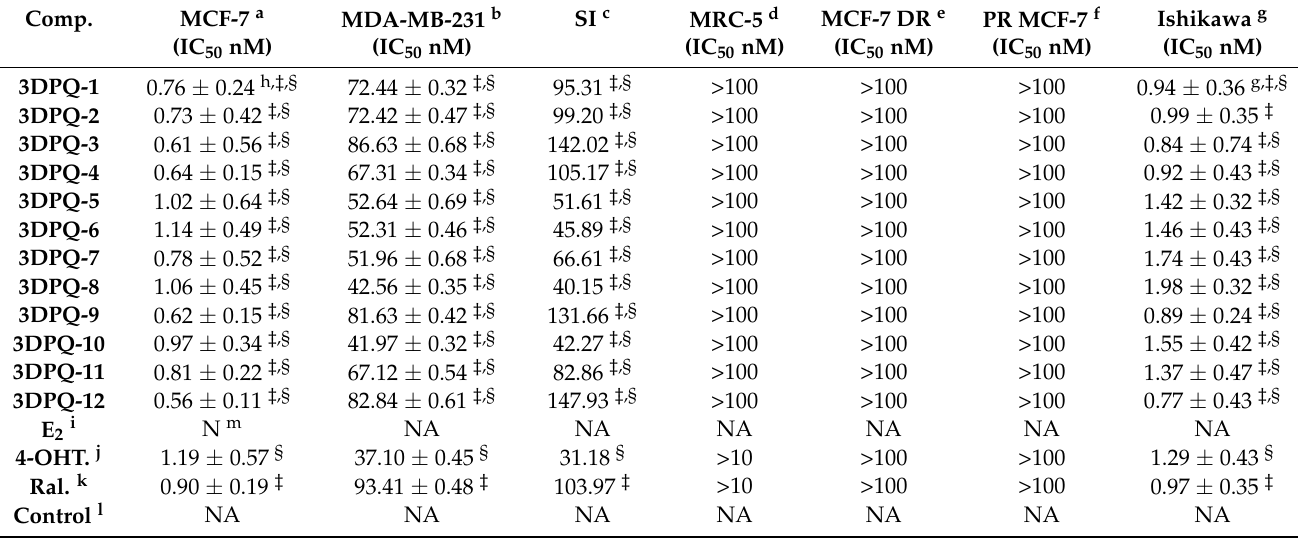
Table 8. Synthesized compound antiproliferative activity and selectivity index against hormone- dependent MCF-7, hormone-independent MDA-MB-231 breast cancer cell lines, normal MRC-5 human lung tissue fibroblasts cell lines, and Ishikawa endometrial adenocarcinoma cell lines, as